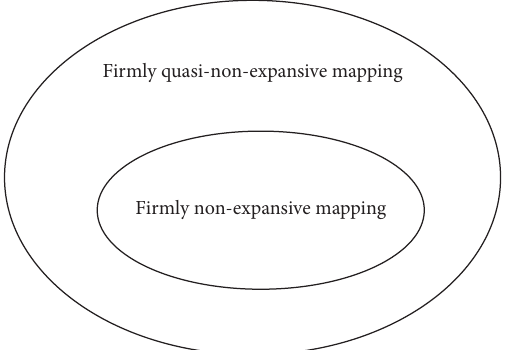
Figure 3: The relations of some nonlinear Algorithm 1. H is a real Hilbert space, and Fix ( U ) ≠ ∅ . 1